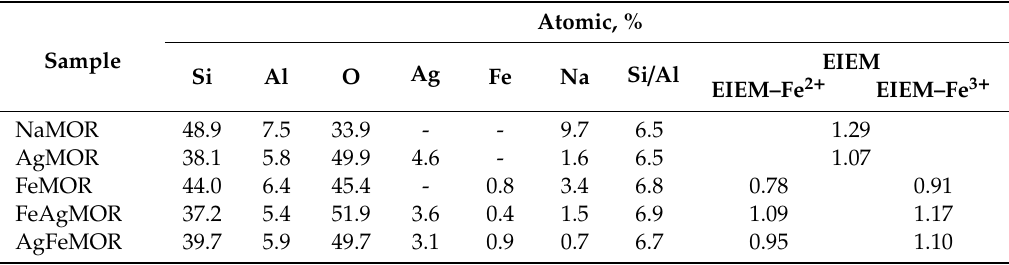
Table 1. Chemical composition of the samples, measured by Inductively Coupled Plasma-Optical Emission Spectroscopy